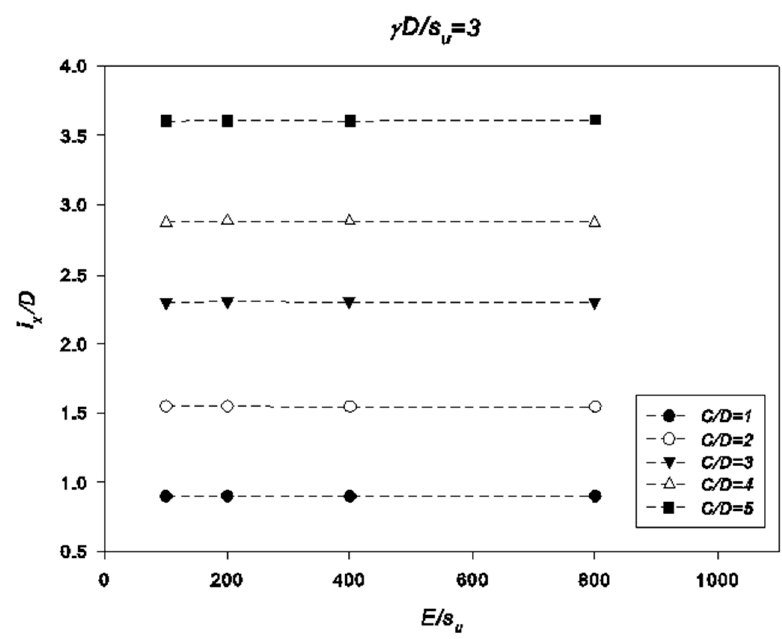
Figure 18. Young’s modulus against i x with respect to C/D .